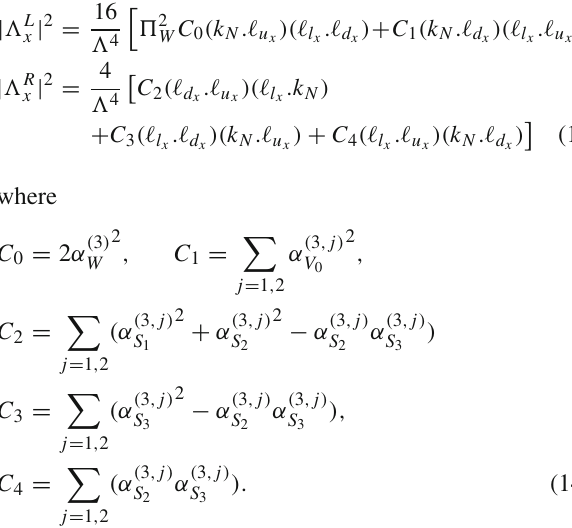
, L | 2 in (12) gives the contribution of a ± polar- Each term | (cid:4) R x